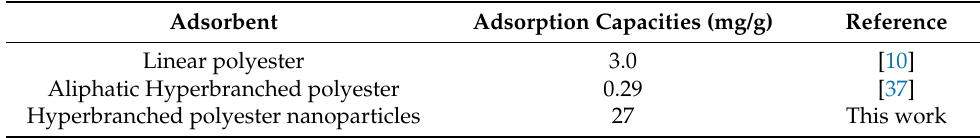
Table 2. Cd(II) adsorption capacities of different adsorbents.